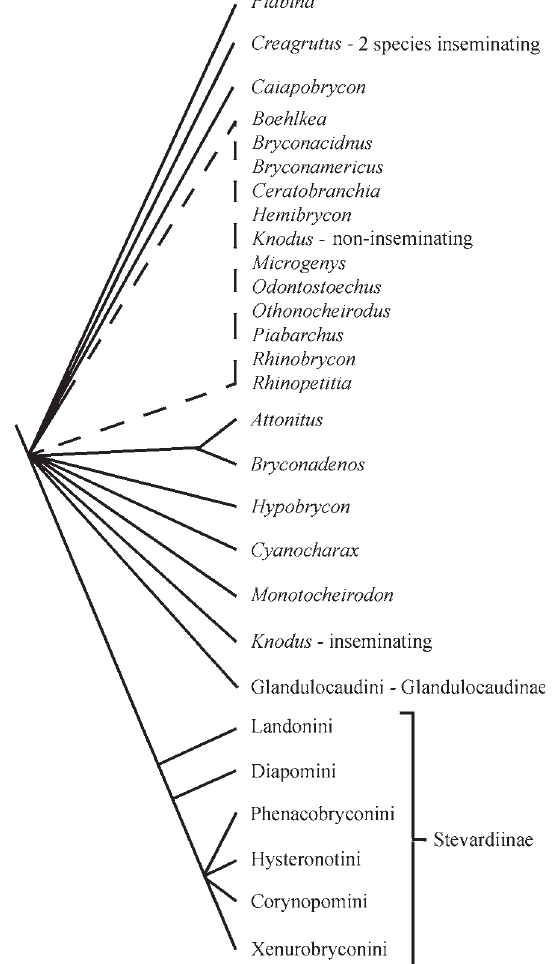
Fig. 11. Cladogram depicting hypothesized relationships among Clade A characids as modified here from Malabarba and Weitzman (2003) with the addition of Bryconadenos shown as a sister group of Attonitus and the placement of genera with inseminating species as possibly more closely re- lated to one another than to non-inseminating Clade A